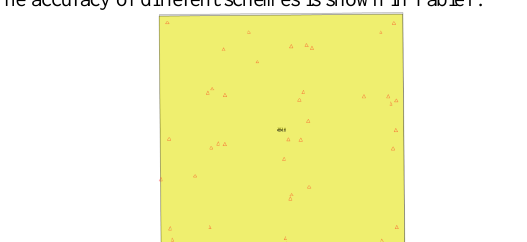
Figure1. Stereo imaging mode